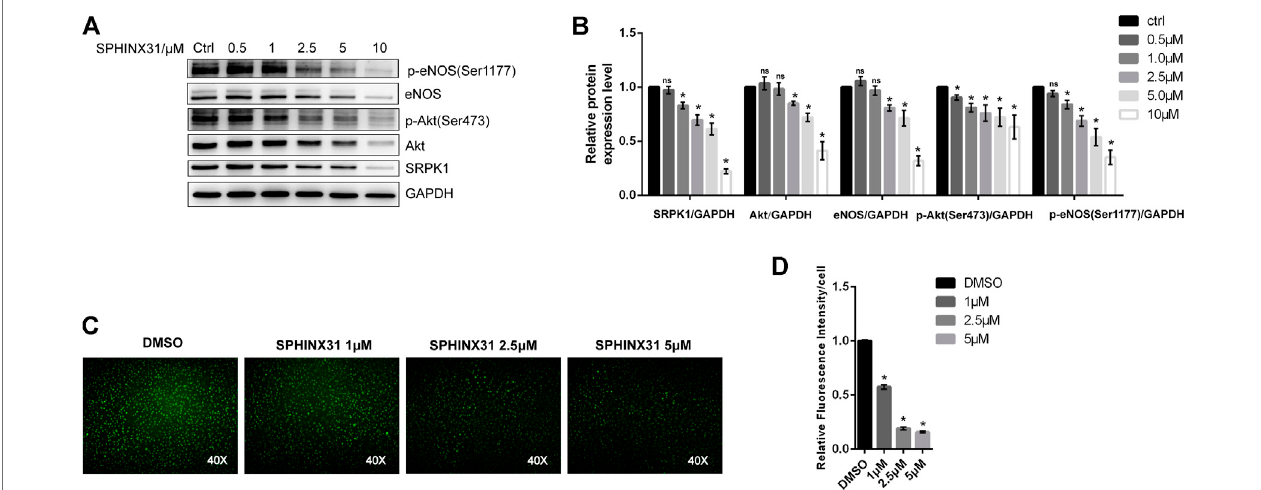
FIGURE 3 | Effects of the inhibitor of SRPK1 on eNOS activity in HUVECs. HUVECs were treated with different concentrations of SPHINX31 for 24 h. The levels of eNOS, phosphor-eNOS (Ser1177), Akt, phosphor-Akt (Ser473), and SRPK1 were determined by western blot (A) with the quanti fi cations of the related proteins (B) . After treatment with different concentrations (1, 2.5, and 5 μ M) of SPHINX31 for 24 h, the immuno fl uorescence images of the NO probe were observed using 40 × fl uorescence microscopy (C) with the quanti fi cations of mean fl uorescence intensity (D) . The data are presented as the mean ± SD of three independent experiments. Signi fi cance was determined by one-way ANOVA with a least signi fi cant difference post hoc test. ns, p > 0.05; *, p < 0.05 vs Ctrl.